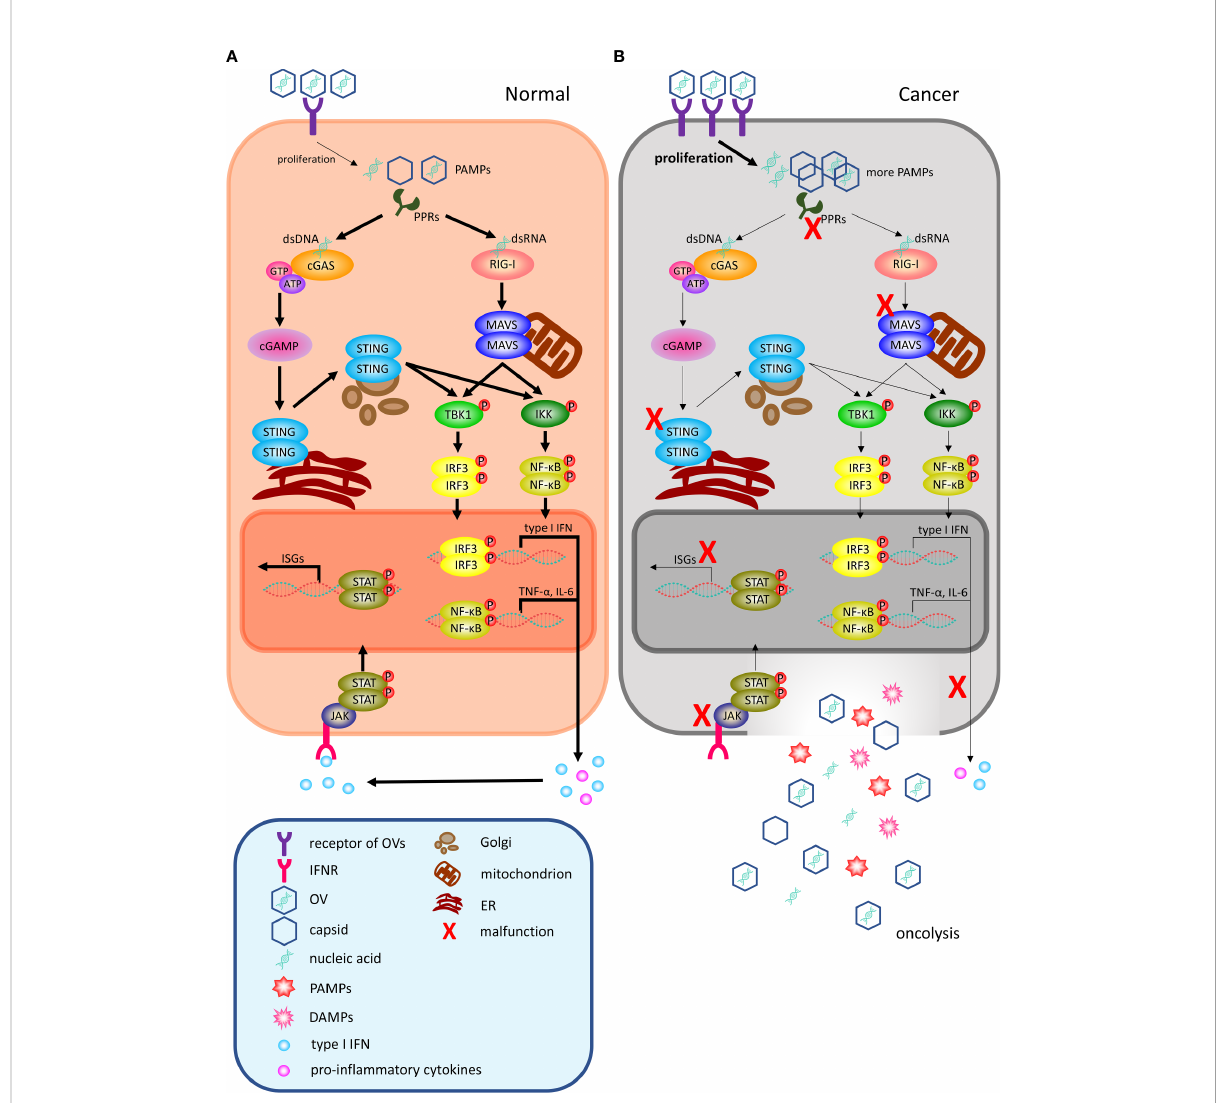
FIGURE 1 OVs can selectively infect and lyse cancer cells locally. (A) Following viral infection, most normal cells activate antiviral pathways against viral infections. The antiviral machinery can be triggered by viral PAMPs that activate PRRs (such as cGAS for DNA viruses and RIG-I for RNA viruses). Once PAMPs are detected, a signaling cascade through the adaptor molecule STING or MAVS phosphorylating IRF3 and NF- k B to dimerize and translocate to the nucleus to regulate the programmed transcription of type I IFN and proin fl ammatory cytokines. Among them, proin fl ammatory cytokines recruit immune cells to in fi ltrate the TME, and local IFN production can promote antiviral activity through IFNR. Upon type I IFN binding to receptors, the activated JAK-STAT signaling pathway leads to the rapid transcription of abundant ISGs to inhibit various stages of the viral lifecycle from invasion to release and can even target infected cells for apoptosis or necrosis. (B) In malignant cells, this process is disrupted. Cancer cells may increase the number of viral receptors or downregulate key signaling components within the innate antiviral signaling pathway, including PPRs, STING, MAVS, type I IFN and ISGs, thereby limiting their proapoptotic and cell cycle regulatory effects. Therefore, OVs can easily reach the critical value of viral load for oncolysis. OV, oncolytic virus; PAMPs, pathogen-associated molecular patterns; DAMPs, damage-associated molecular patterns; PRRs, pattern-recognition receptors; dsDNA, double-stranded linear DNA; dsRNA, double- stranded linear RNA; cGAS, cyclic GMP – AMP synthase; ATP, adenosine triphosphate; GTP, guanosine triphosphate; cGAMP, cyclic GMP – AMP; ER, endoplasmic reticulum; TBK1, TANK-binding kinase 1; IKK, I k B kinase; IRF3, interferon regulatory factor 3; NF- k B, nuclear factor- k B; RIG-I, retinoic acid- inducible gene I; TNF- a , tumor necrosis factor- a ; IL-6, interleukin-6; ISGs, interferon-stimulated genes; IFN, interferon; IFNR, interferon receptor; JAK, Janus kinase; STAT, signal transducer and activator of transcription; TME, tumor